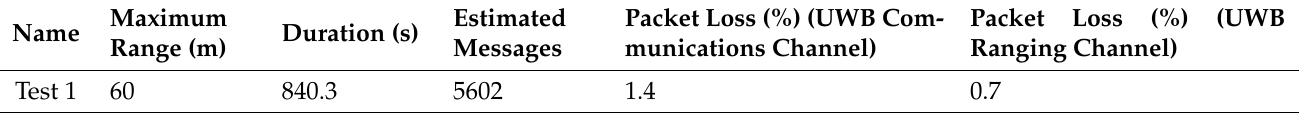
Table 5. Results in test 1 of the amount of communications exchanged and ranging messages.